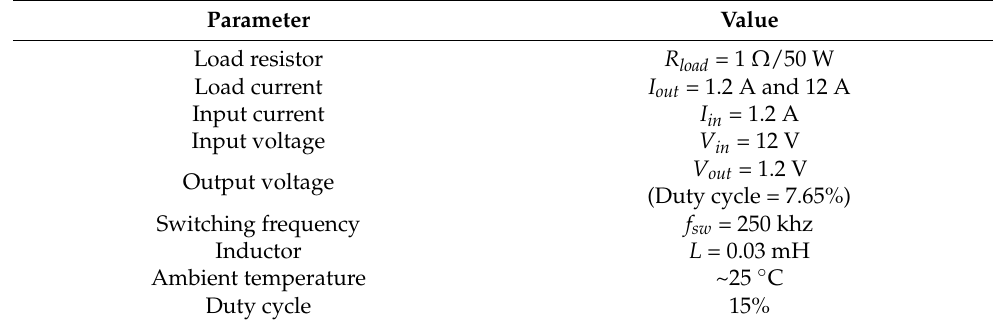
Table 3. Parameters of the tested PoL buck converter.